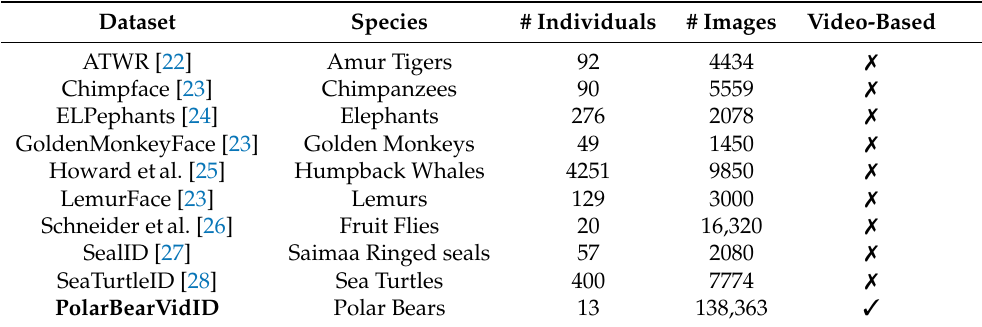
Table 1. Publicly available datasets for the task of re-ID in animals. The PolarBearVidID dataset is the only one providing video sequences of the animals. Therefore, this dataset is the only one to make is possible to utilize the individuals’ movement as a unique feature for